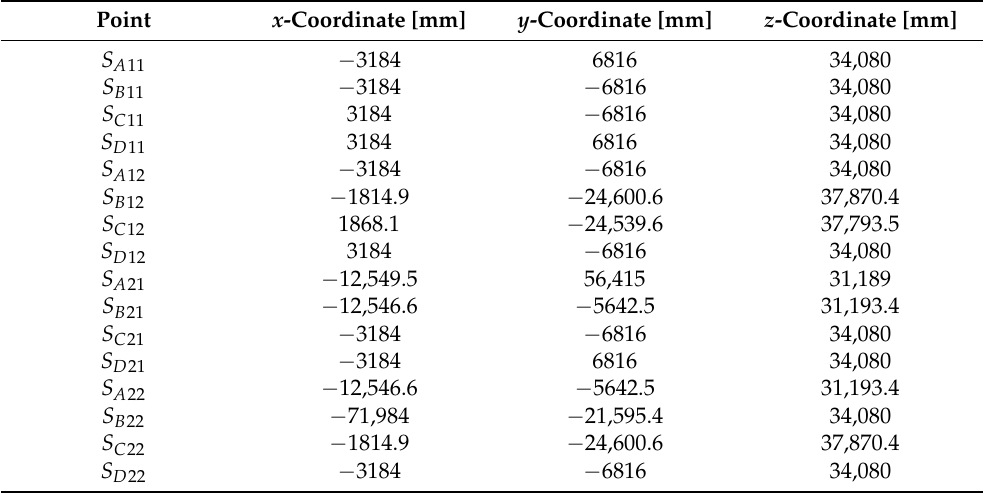
Table A6. The coordinates of the points defining the reference surface ω 2 of the second structure Σ 2 .